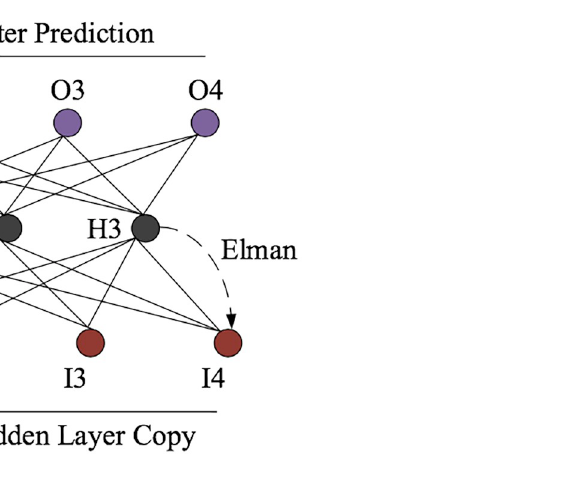
Fig 3. Schematic diagram of the Elman neural network structure.